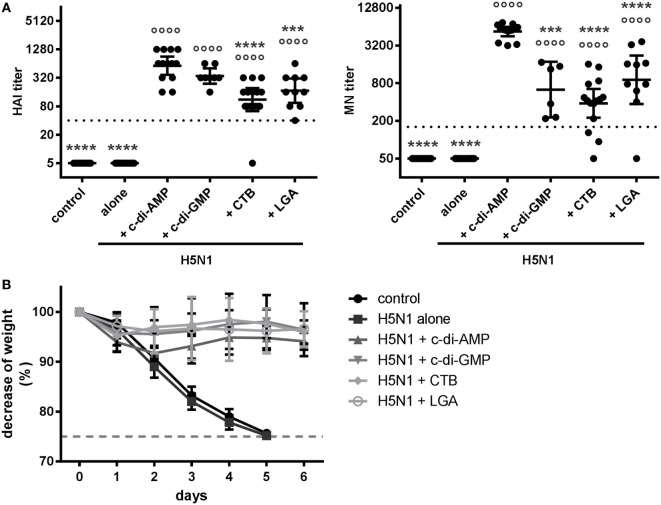
Protection. (A) Correlates of protection. Groups of 3–5 BALB/c mice were immunized intranasally with PBS (control) or with two doses (21 days apart) of H5N1 virosomes [7.5 µg hemagglutinin (HA)], alone or adjuvanted with cyclic di-adenosine monophosphate (c-di-AMP) (5 µg), c-di-GMP (5 µg), cholera toxin subunit B (CTB) (10 µg), or last (or third) generation adjuvant (LGA) (7.5 µg). At 21 days after the second immunization, blood was sampled and sera obtained. The HAI and MN titers against homologous virosomes were measured in n = 4 (alone), n = 3 (control, c-di-AMP, CTB), n = 2 (LGA), or n = 2 (c-di-GMP) independent experiments, presented as one symbol per animal. The lines represent the geometric mean of the titers with 95% CI. Negative samples were assigned a value below the detection limit (5 for HAI and 50 for MN) for calculation purposes. The dotted line represents the protective HAI titer of 40 or MN titer of 160, respectively. Statistically significant differences were measured by one-way ANOVA with Tukey’s post hoc test of the log2 normalized data; differences from the c-di-AMP or antigen alone group are shown by asterisks or circles, respectively (*/°p < 0.05, **/°°p < 0.01, ***/°°°p < 0.001, ****/°°°°p < 0.0001). (B) Protection against virus challenge infection. BALB/c mice were immunized intranasally with PBS (control, 11 animals) or with two doses (21 days apart) of H5N1 virosomes (7.5 µg HA), alone (9 animals) or adjuvanted with c-di-AMP (5 µg, 11 animals), c-di-GMP (5 µg, 9 animals), CTB (5 µg, 9 animals), or LGA (5 µg, 8 animals). Four weeks after the second immunization, mice were intranasally challenged with 2 × 103 ffu of NIBRG-14; the mean percentage changes in body weight (± SD) were calculated. One control animal did not show any clinical symptoms or weight loss and was excluded. According to local regulations, animals showing more than 25% weight loss (dashed line) were euthanized.